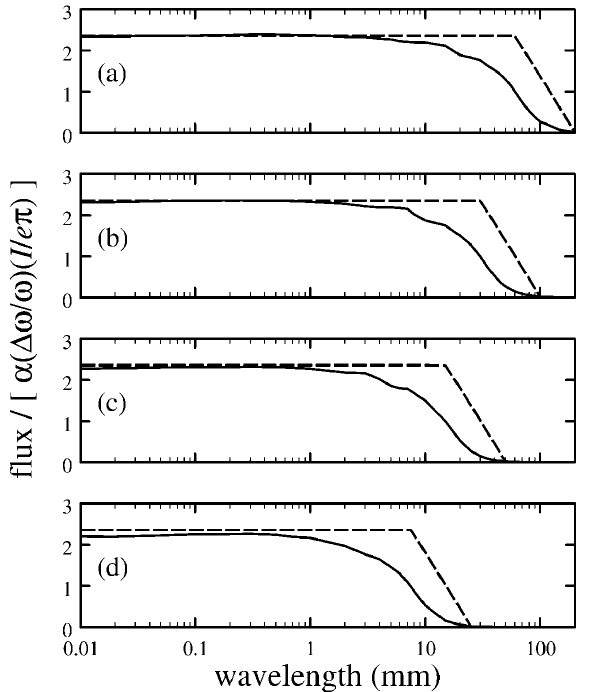
FIG. 5. Extracted flux versus wavelength from a mirror with a hole radius of 9.5 mm, for different values of R 0 , the distance from the axis to the extraction window. Solid line: computed flux. Dashed line: approximate flux from Eq. (19). (a) R 0 (cid:1) 32 mm, (b) R 0 (cid:1) 64 mm, (c) R 0 (cid:1) 128 mm, and (d) R 0 (cid:1) 256